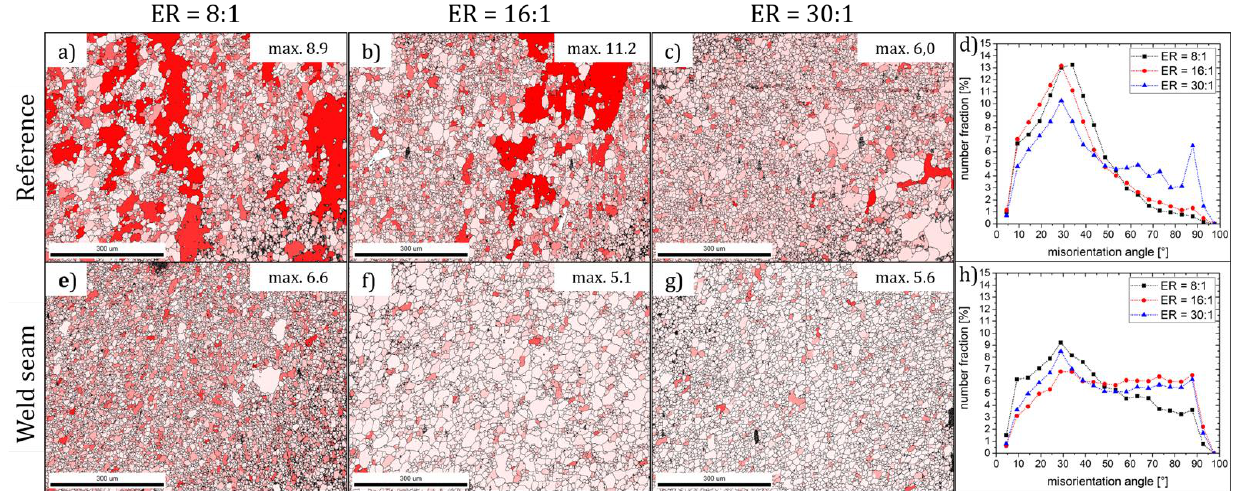
Figure 9. Computed grain orientation spread (GOS) in the reference area of profiles extruded with an extrusion ratio of ( a ) ER = 8:1, ( b ) ER = 16:1, and ( c ) ER = 30:1 and the corresponding weld seams of ( e ) ER = 8:1, ( f ) ER = 16:1, and ( g ) ER = 30:1. Higher internal misorientation are proportional to the intensity of a red color and black lines representing HAGBs (θ > 15°). Misorientation distribution is shown in ( d ) and ( h ) for reference area and weld seam, respectively.